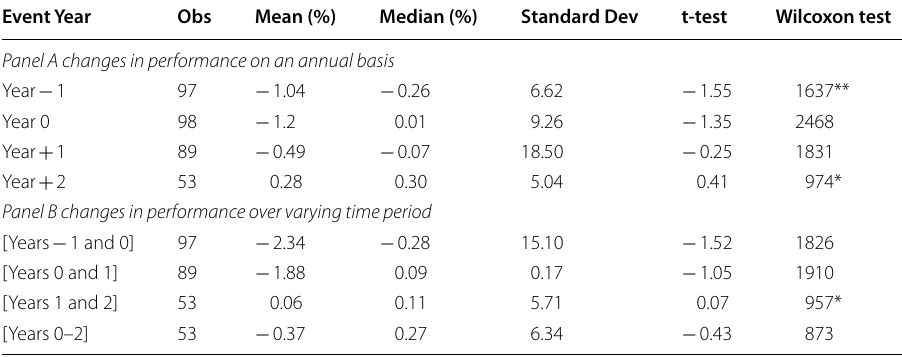
Table 11 Sample firm’s mean and median adjusted Return on Assets (ROA) based on portfolio of control